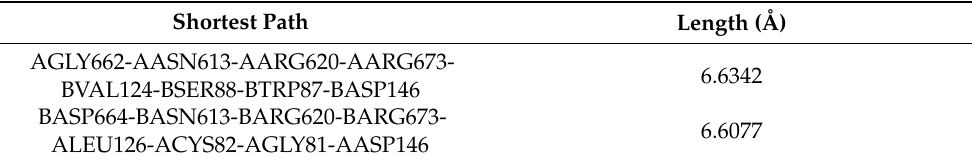
Table 3. Shortest path between RdRp and MTase catalytic